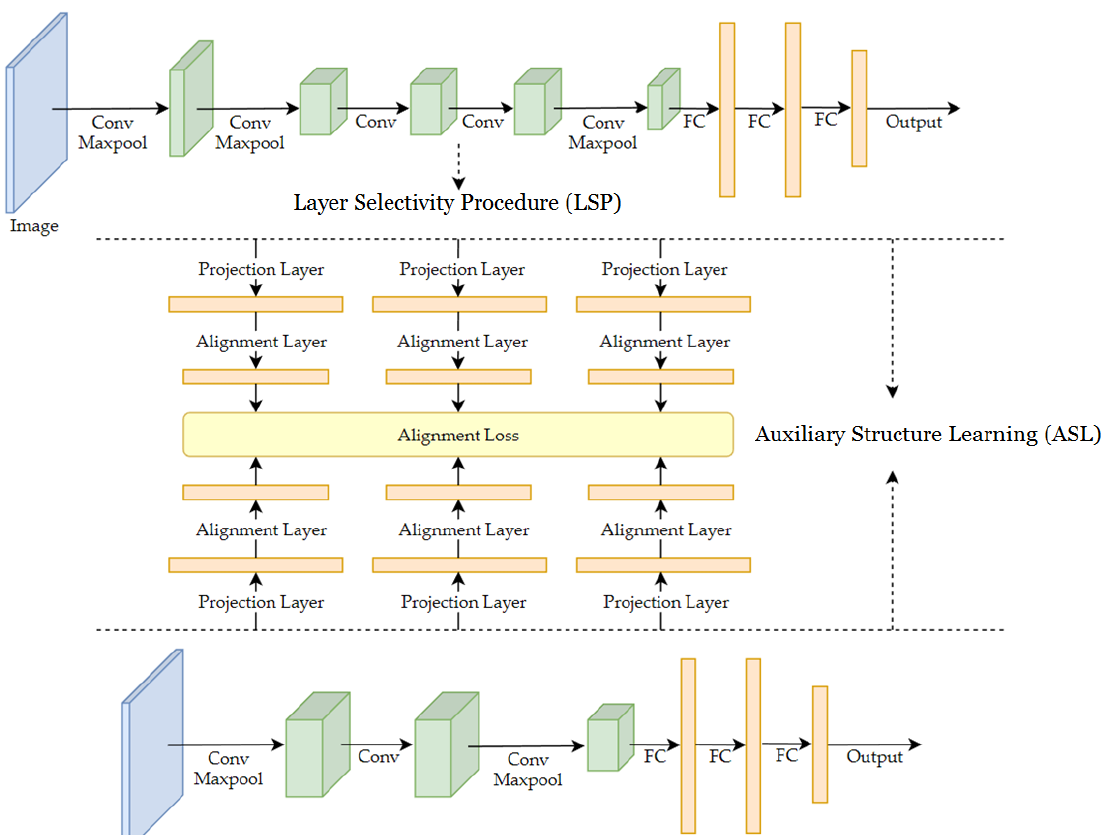
Figure 1. Complete architecture of the Layer Selectivity Learning (LSL) framework.